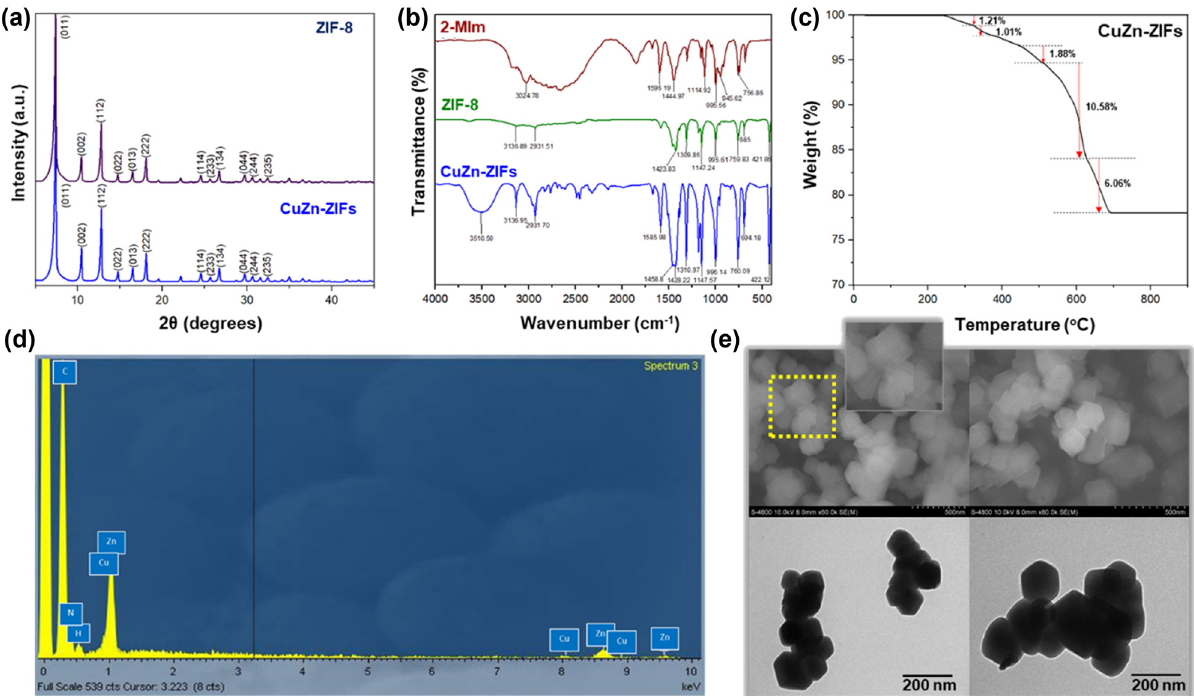
Figure 1: ( a ) X - ray di ff raction patterns of ZIF - 8 and CuZn - ZIFs, ( b ) FT - IR patterns of ZIF - 8 and CuZn - ZIFs, ( c ) TGA curve of CuZn - ZIFs, ( d ) EDX spectrum of CuZn - ZIFs, and ( e ) SEM and TEM images of CuZn -